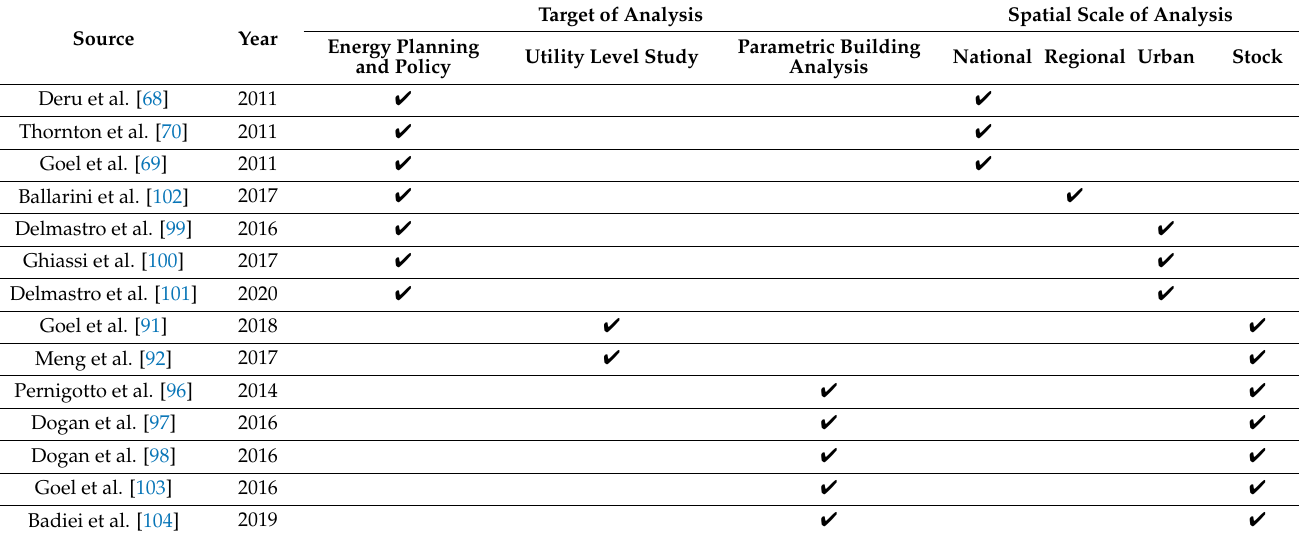
Table 3. Building energy performance analysis—Target and spatial scale of